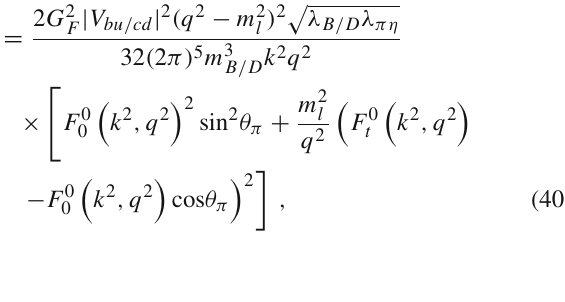
(cid:4) (cid:3) (cid:4) (cid:3) q 2 q 2 and c ± ζ 2 in Eq.